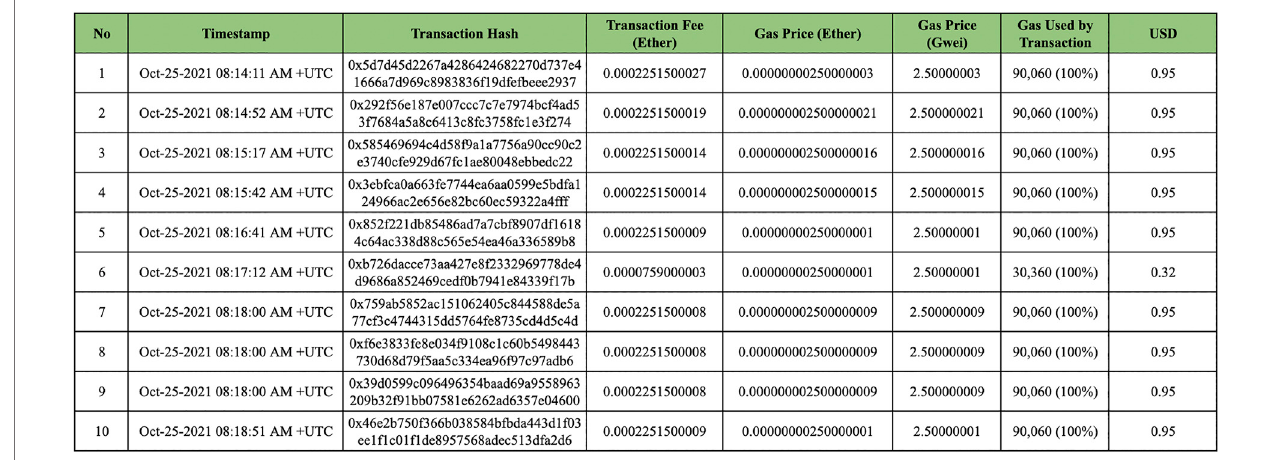
FIGURE 10 | EESP Performance